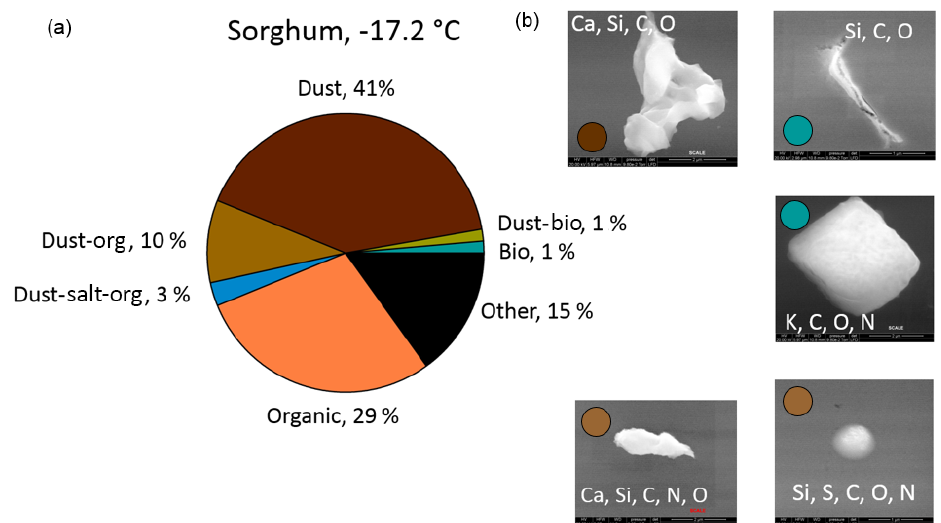
Figure 3. Relative amounts of different particle types collected via impaction and analyzed using SEM-EDX (a) and example SEM images with the corresponding elemental composition measured with EDX shown in white (b) . The colored circle in the left corner of the images indicates which chemical class the particles were classified as. These data were collected during a sorghum harvest with a CFDC operating temperature of − 17 ◦ C. In total, 73 particles were analyzed to make this pie